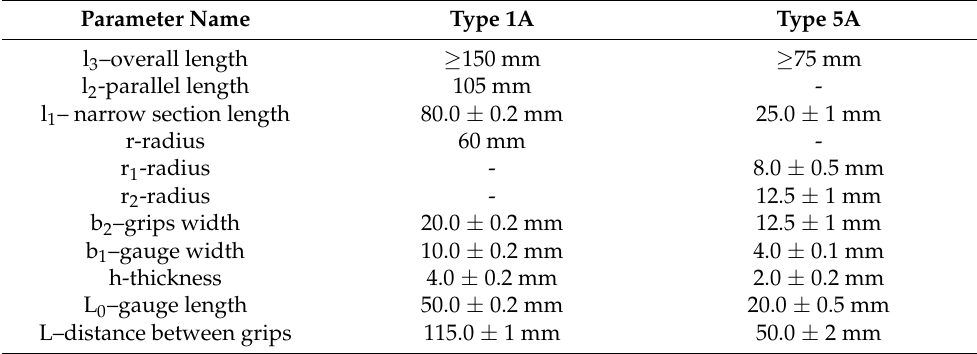
Table 1. Detailed dimensions of the samples.